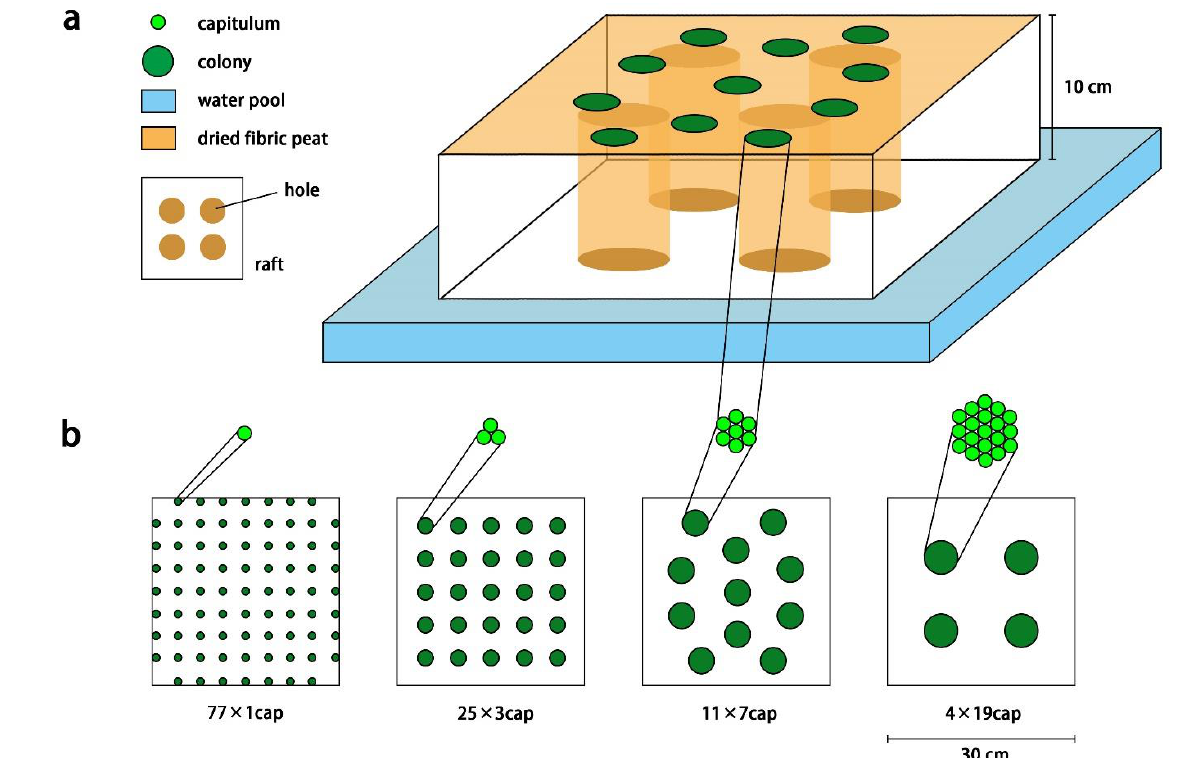
Figure 3. Diagrams showing the arrangement of floating polystyrene raft and Sphagnum colonies (a) and the structure and arrangement of colonies in the ‘77×1cap’, ‘25×3cap’, ‘11×7cap’ and ‘4×19cap’ planting treatments, which consisted of 77, 25, 11 and 4 colonies of 1, 3, 7 and 19 capitula, respectively (b).